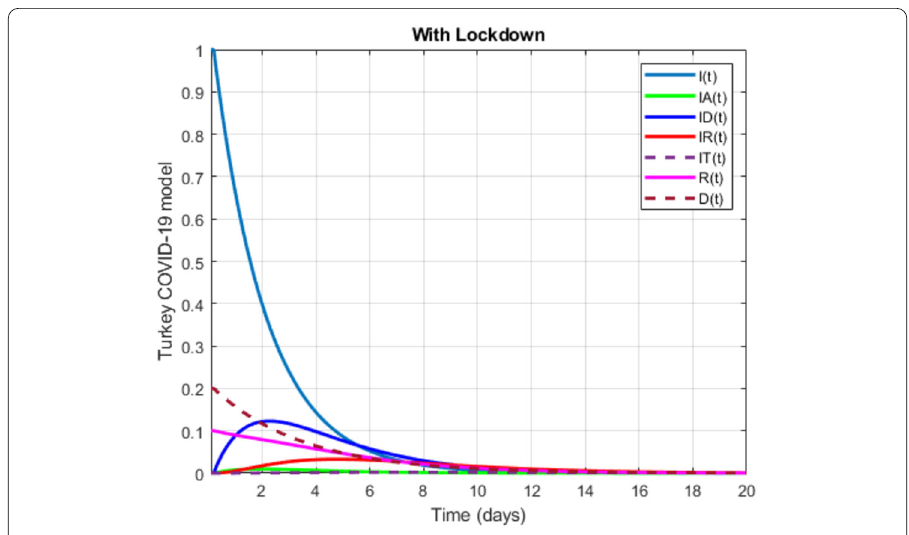
Figure 36 Numerical visualization for Covid-19 model in